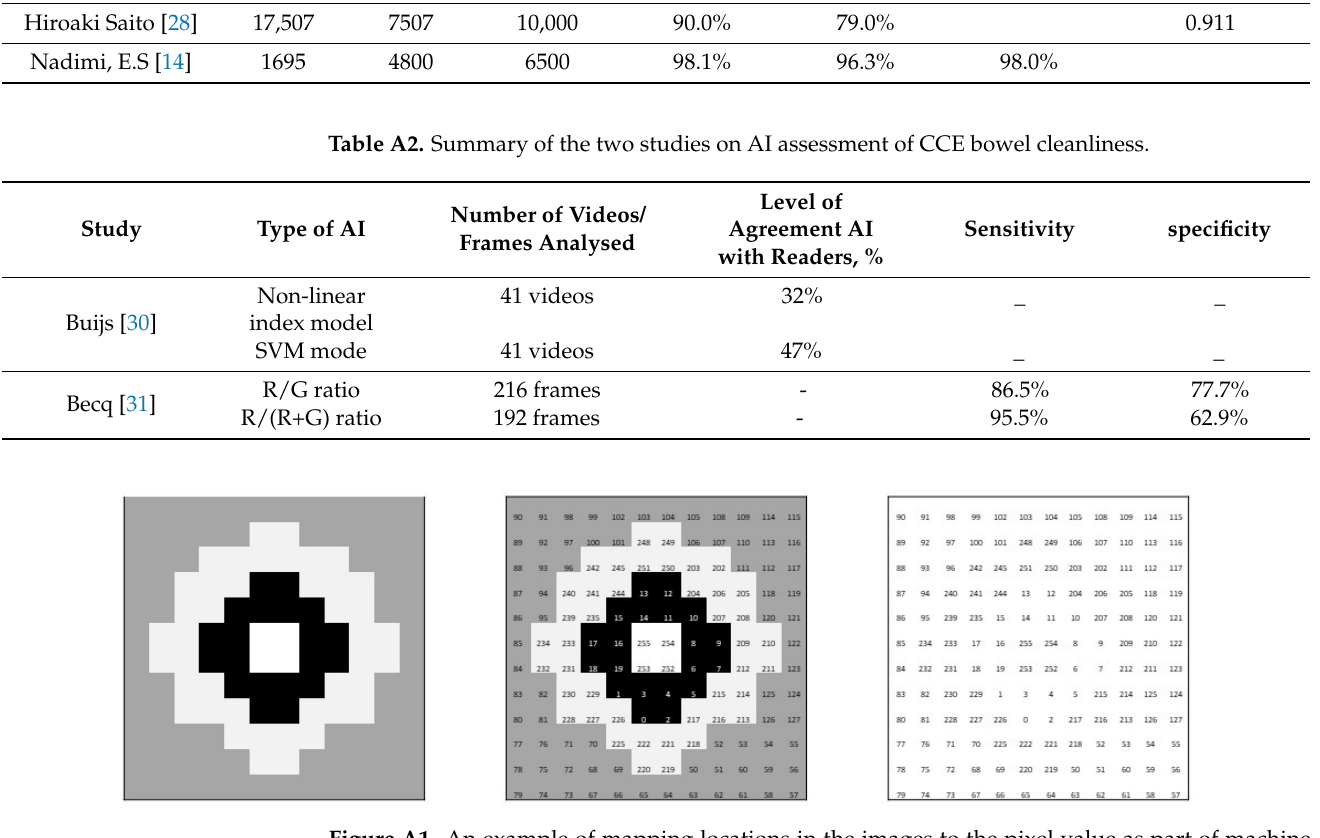
Figure A2. The intrinsic method or behaviour of the AI code in the model is uninterpretable, like a black box with no transparency. References 1.